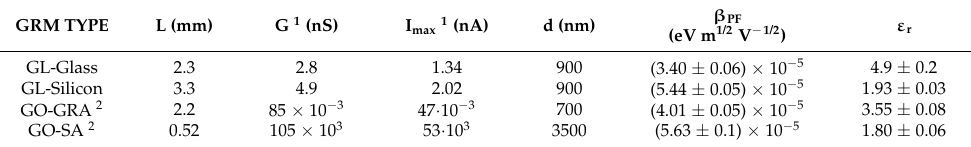
Table 2. Sample main electrical transport parameters. L, G, I max , d, β PF , and ε r represent the length between the Al contacts made on the film, the conductance, the max current that passes through the films when V = 0.5 V is applied, the thickness, the Poole–Frenkel constant, and the relative permittivity, respectively. The geometrical dimensions were evaluated by performing a post-analysis of the recorded high-resolution optical images.